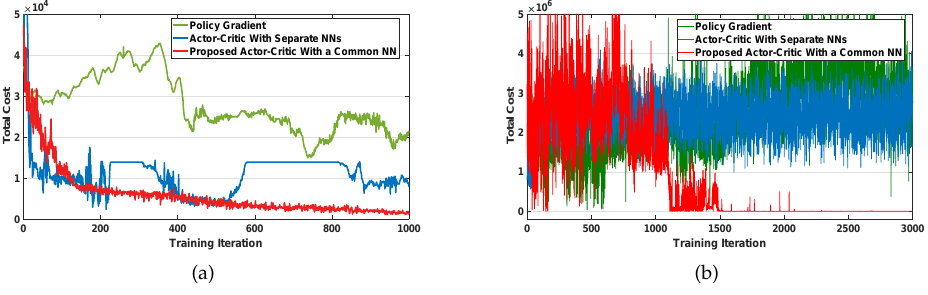
Figure 9. Convergence of the total cost. ( a ) Level 1; ( b ) Level